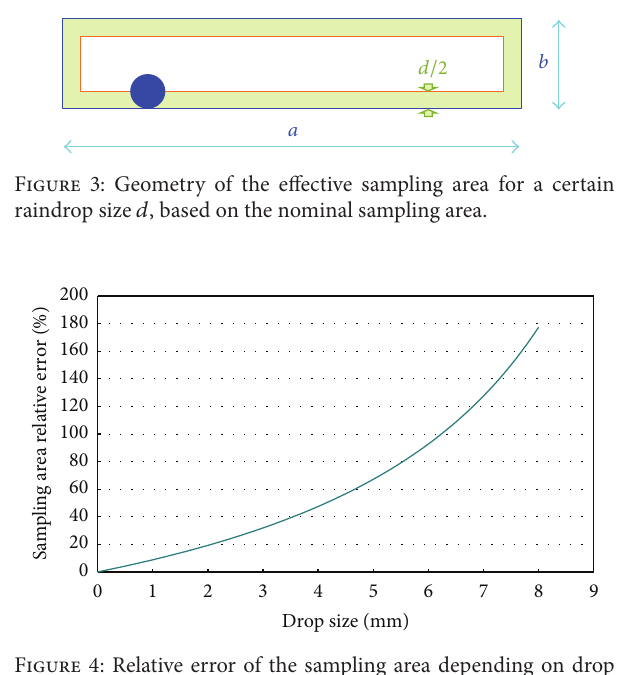
Figure 4: Relative error of the sampling area depending on drop size.